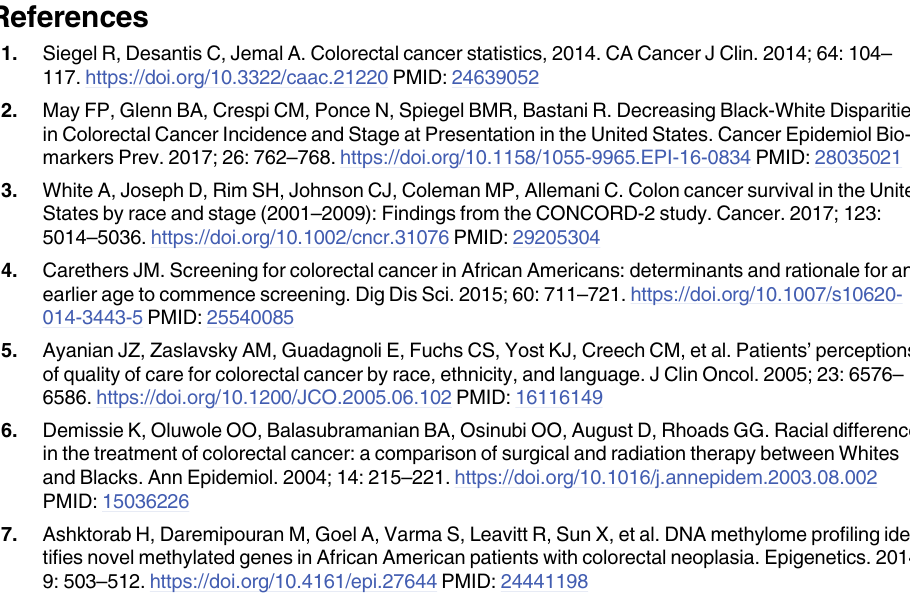
S1 Table. Kaplan-Meier analysis of variables associated with overall survival (OS; days, mean ± 1SE). S2 Table. Kaplan-Meier analysis of variables associated with disease free survival (DFS; days, mean ± 1SE). S3 Table. Frequency � of KRAS mutation among African American (AA) and white patients relative to conventional and newly proposed localization of colorectal